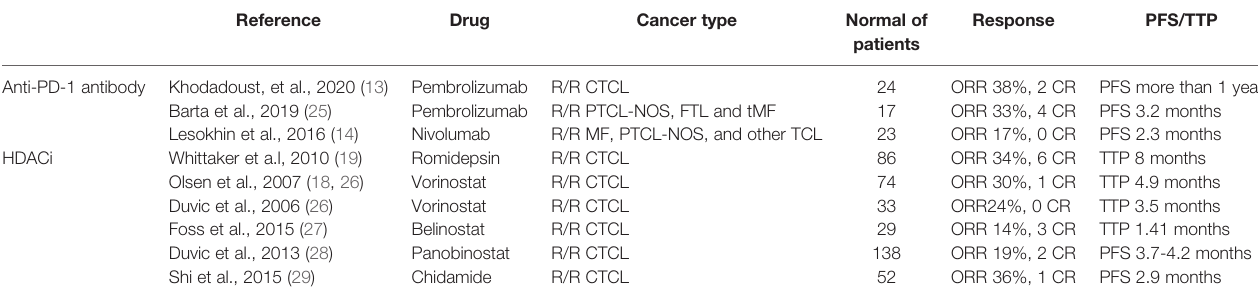
TABLE 2 | Clinical effects of anti-PD-1 and HDACi as a single drug in CTCL.